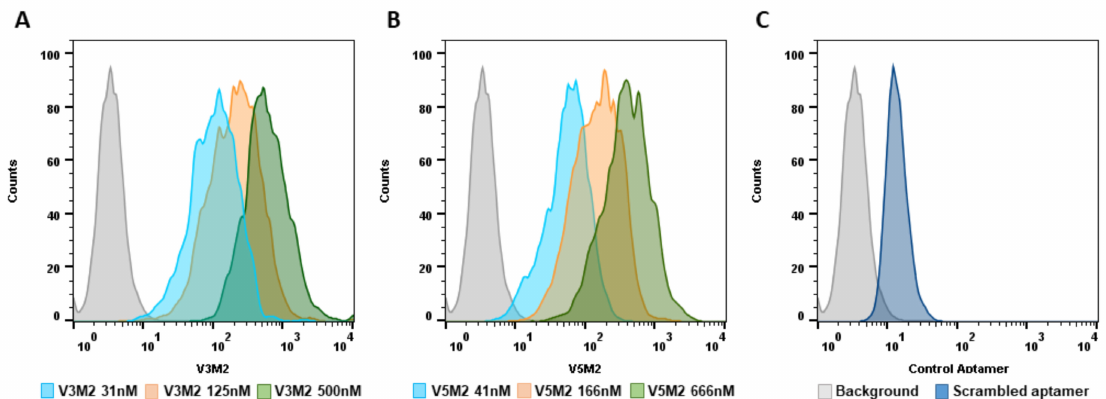
Figure 4. Dose-dependent binding of selected motifs. Biotin conjugated V3M2 and V5M2 were incubated with vimentin- expressing IGROV cells at various concentrations and followed by streptavidin-FITC staining. Their binding affinity was analyzed by flow cytometry. Histograms presenting the fluorescence intensity above the background were shown for V3M2 ( A ) and V5M2 ( B ). A scrambled control aptamer with non-specific and low binding affinity is also assessed ( C ).